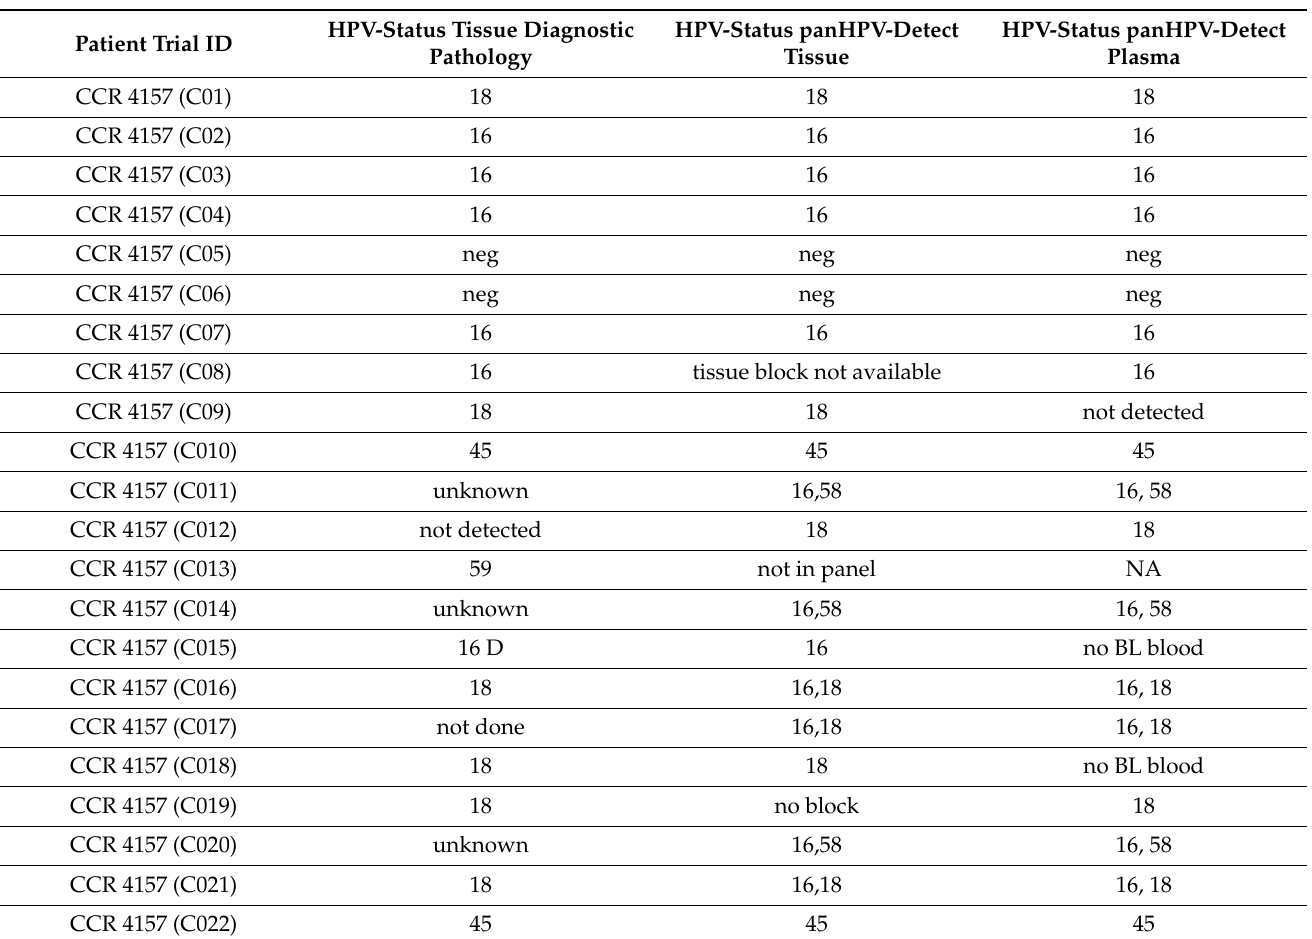
Table 4. Details the HPV status in tissue at diagnostic pathology and in tissue and plasma using